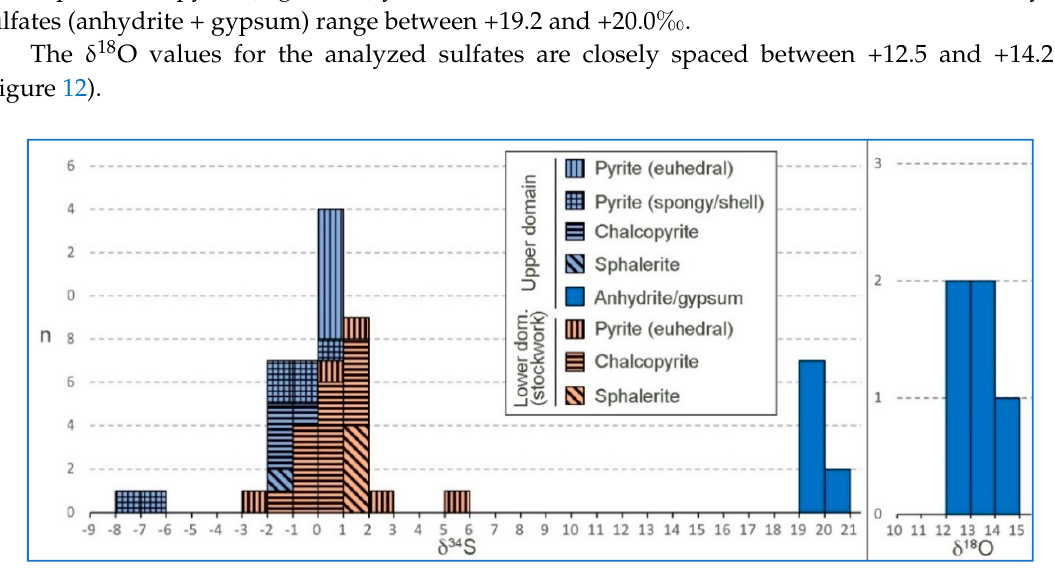
Figure 12. Histograms showing the range of sulfur ( ‰ , Canyon Diablo Troilite standard) and oxygen (Vienna-standard mean ocean water standard) isotope data for sulfides and sulfates from the Romero deposit.